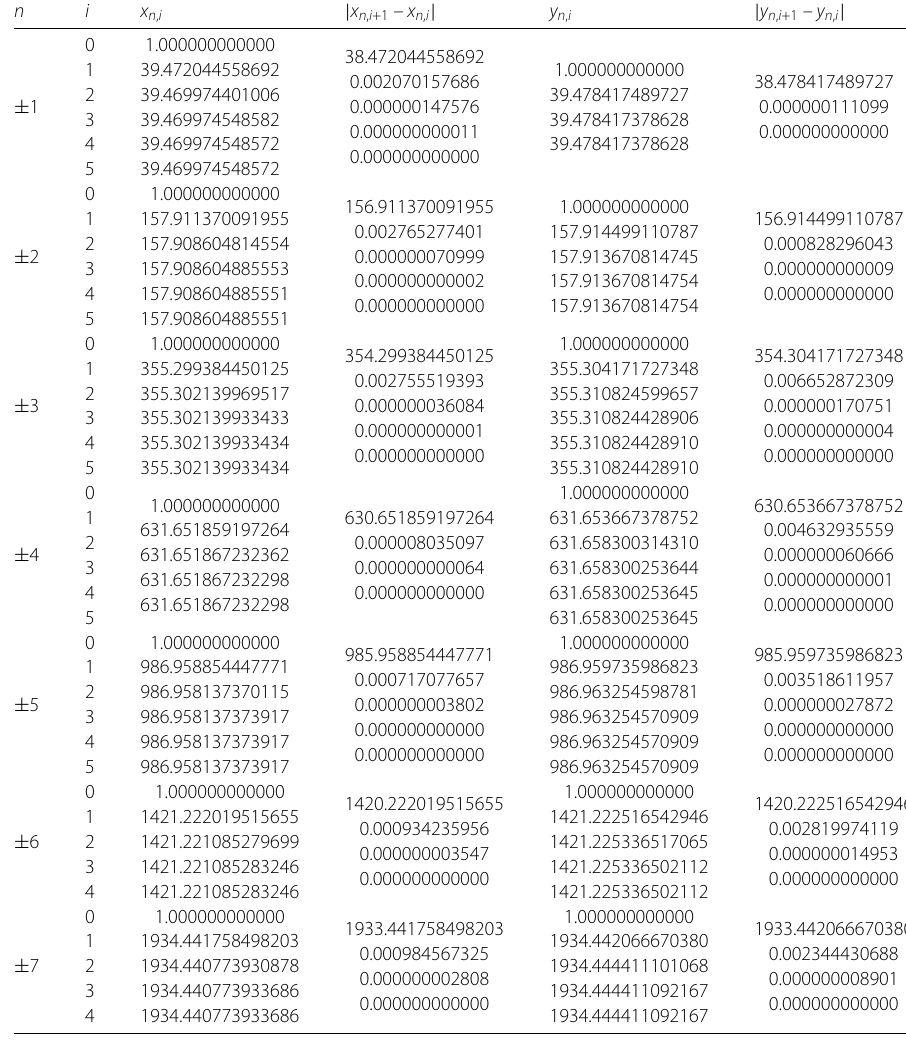
Table 1 Estimations of eigenvalues for q ( x ) = 2cos(2 π x